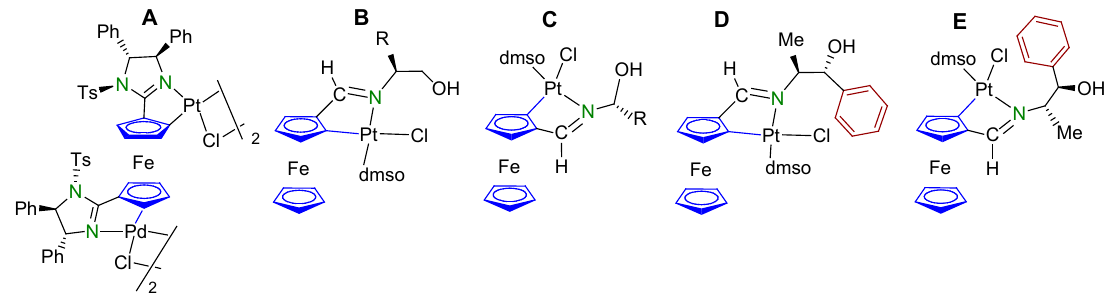
Figure 2. Representative examples of diastereomerically pure cyclometallated Pt(II) complexes containing a σ (Pt–C Fc ) bond [39–43]. (For types B and C , R is Me or i